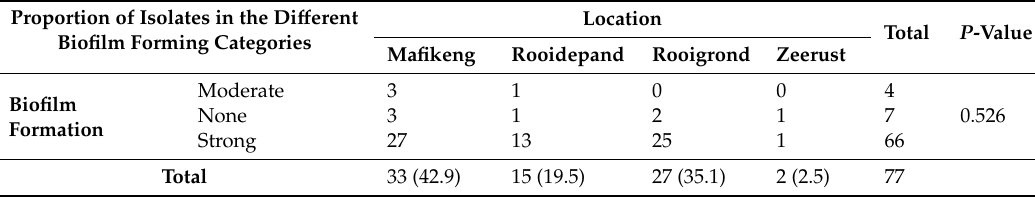
Table 1. Distribution of biofilm formation with respect to study location.